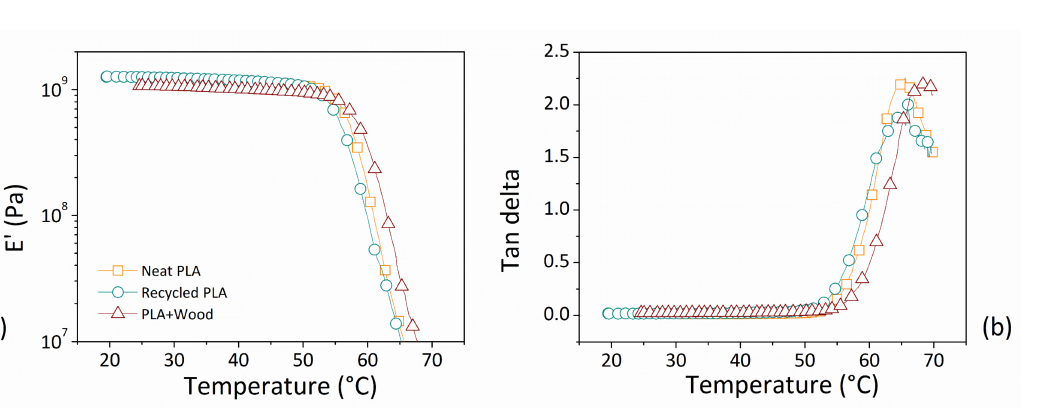
Figure 6. ( a ) Storage modulus (E’) and ( b ) dissipation factor as a function of temperature for investigated materials. (Legend is the same in ( a ) as in ( b